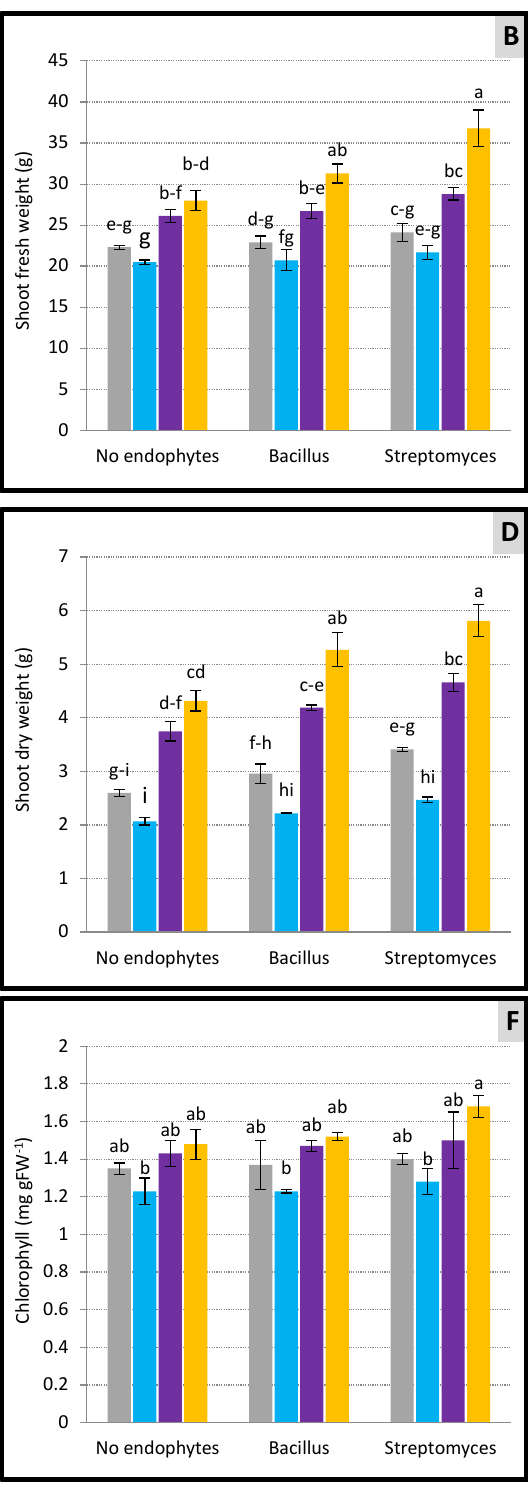
Figure 2. Interactive effect of endophytic microorganisms and abiotic elicitors on ( A , B ) shoot fresh weight, ( C , D ) shoot dry weight (g); and ( E , F ) chlorophyll concentration (mg g −1 FW) in periwinkle plant shoot in both seasons. Columns with the same letter in each chart are non-significantly ( p ≤ 0.05) different according to Tukey’s test. Means of five replicates are presented with ±SE. The promoting effect of endophytes or abiotic elicitors recorded in the current inves- tigation is consistent with earlier reports that indicated that inoculation with endophytes [19,20], application of tryptophan [23,54], or chitosan [29,30] possibly will boost the plant